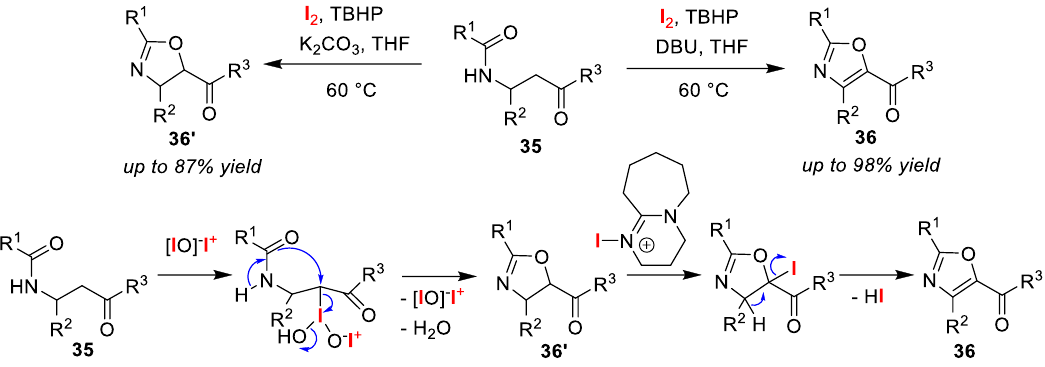
Figure 18. Selective synthesis of oxazoles 36 and oxazolines 3 6′ via the oxidative cyclization of β - acylamino ketones 35 using I 2 and TBHP under basic conditions.